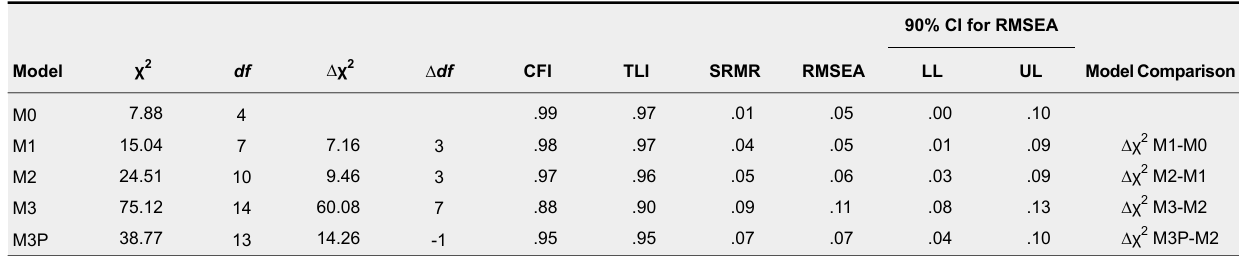
Goodness-of-fit Indices and Comparison of Models Testing Measurement Invariance for Legitimacy of Protests (Simplified Scale)